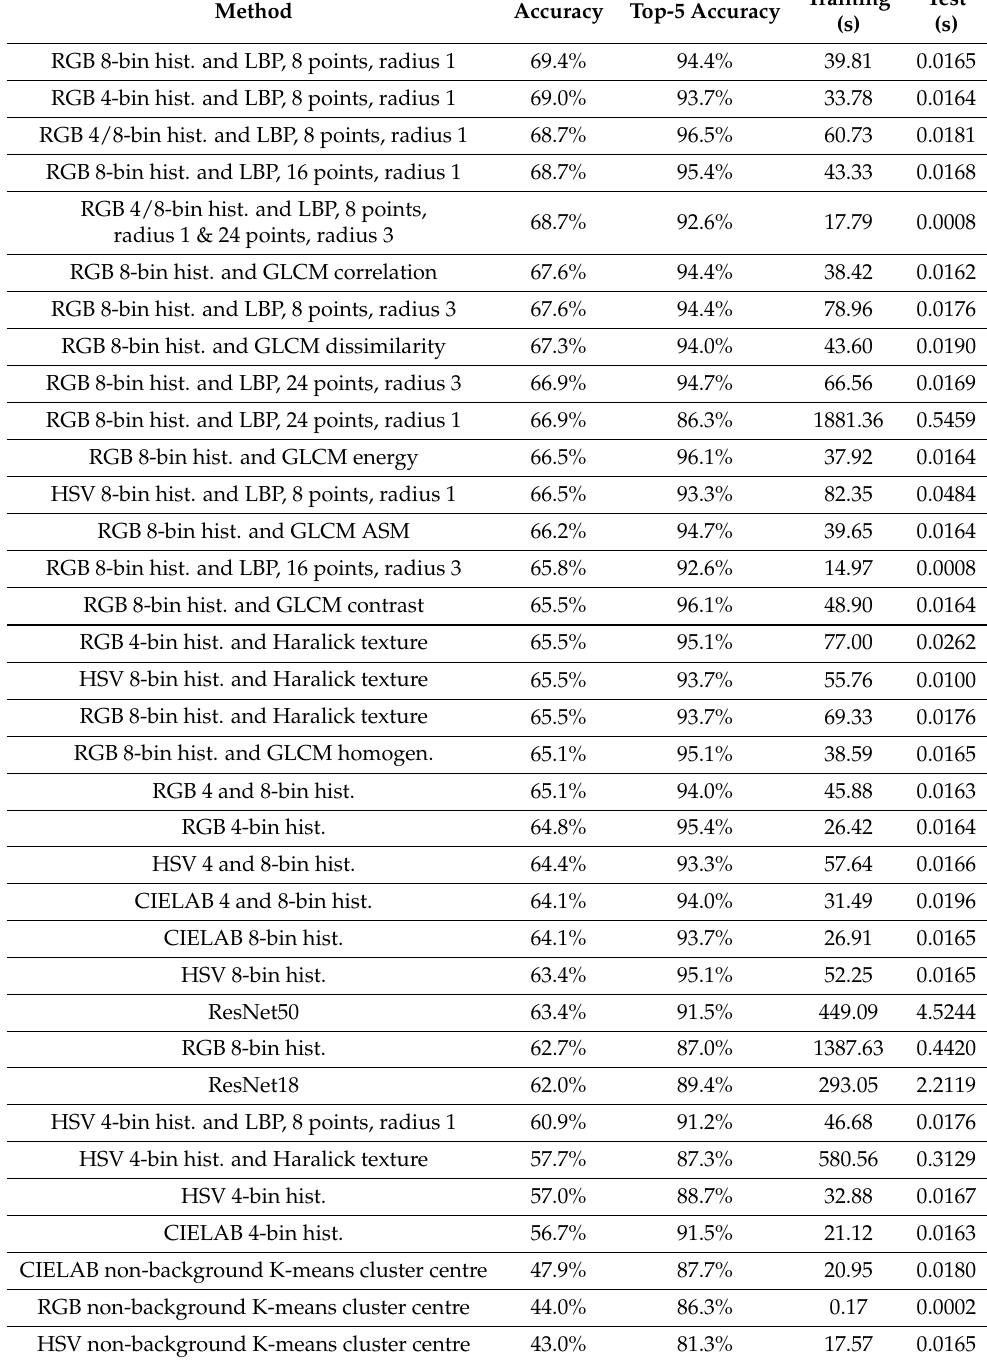
Table 4. Accuracy, top-5 accuracy, training and test time of the most accurate classifier for each feature extraction method. The system based on the RGB 8-bin histogram and the LBP with 8 points at radius 1 yielded the highest accuracy of 69.4%. The highest top-5 accuracy of 96.5% was attained by the system using the RGB 4 and 8-bin histograms and the LBP with 8 points at radius 1. It should be noted that unlike the other algorithms, the ResNets were trained and tested on a Graphics Processing Unit (GPU) instead of a Central Processing Unit